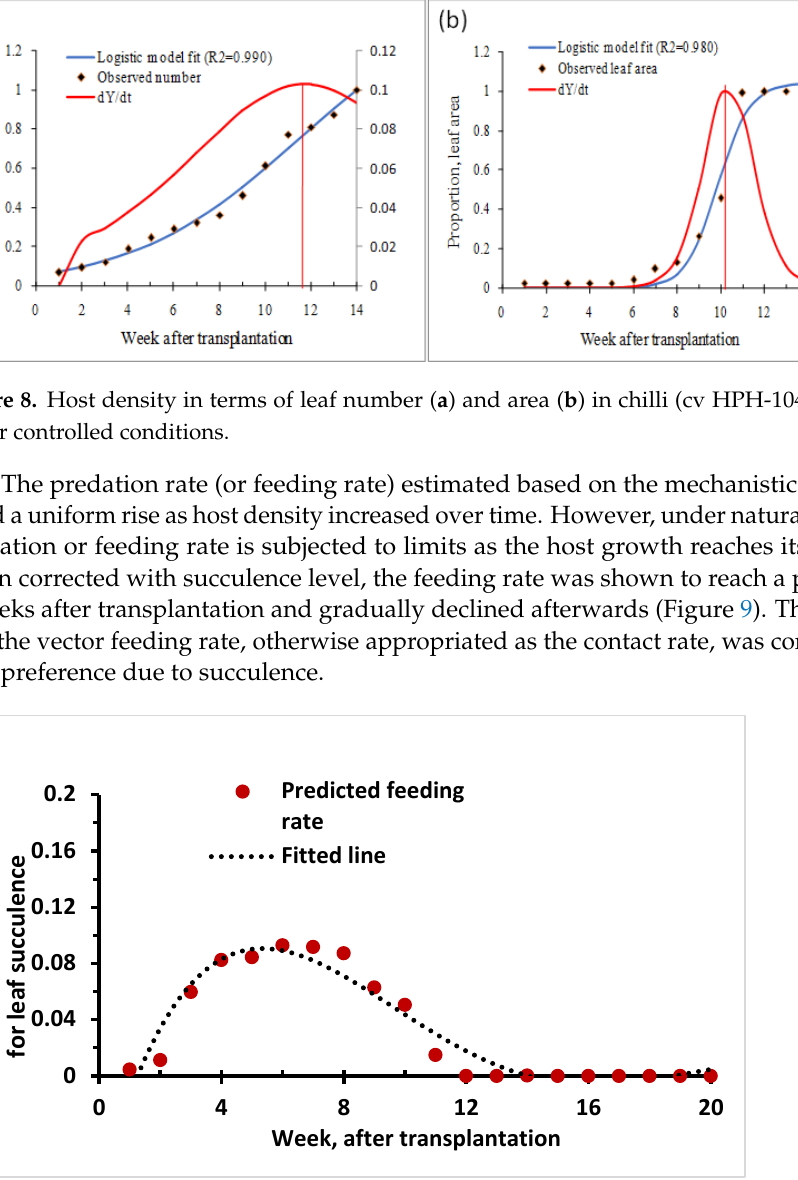
Figure 9. Dynamics of vector predation or feeding rate predicted in chilli based on host density and corrected for host succulence.